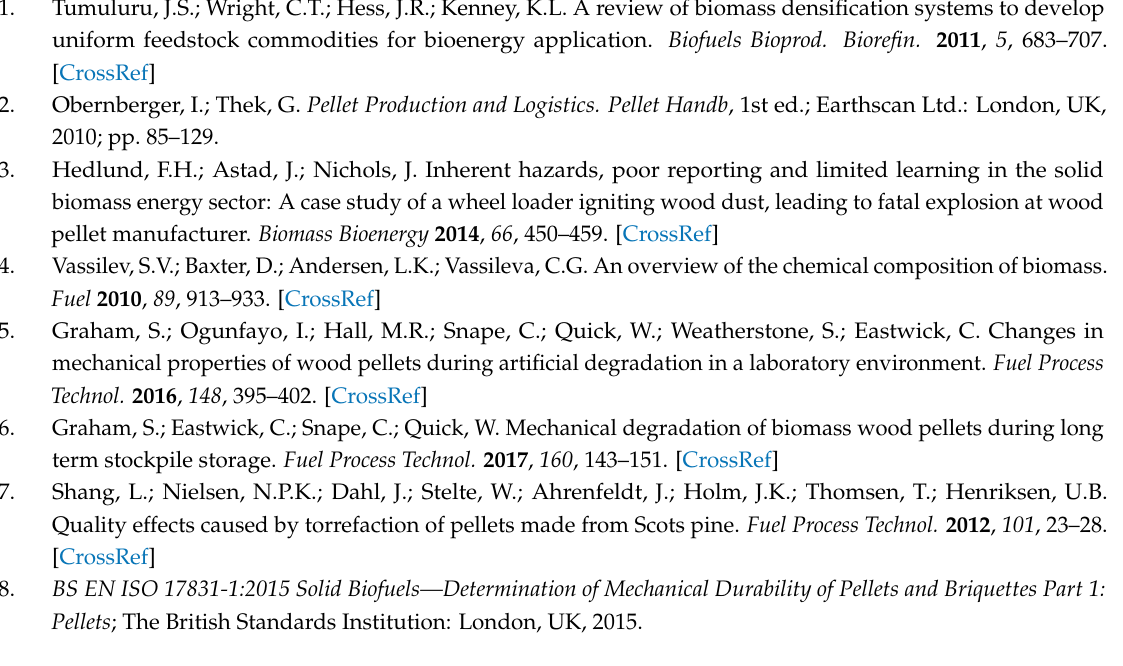
s1, Figure S1: Typical quasi-static stress strain curves for biomass pellets in axial (a), diametric (b), and flexure (c) orientations. Figure S2: Biomass pellet quasi-static diametric elastic strain versus HGI (HGI n = 2, strain data n = 10). Figure S3: Ring-Roller (a) and knife mil (b) energy against biomass pellet quasi-static diametric proportional stress (milling energy n = 3, stress data n = 10). Figure S4: Typical dynamic stress strain curves for biomass pellets in axial (a) and, diametric (b),